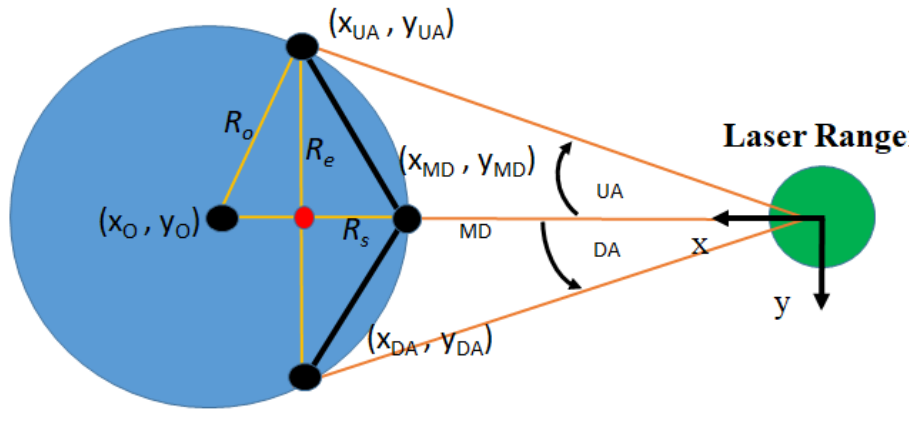
Figure 6. Square obstacle.